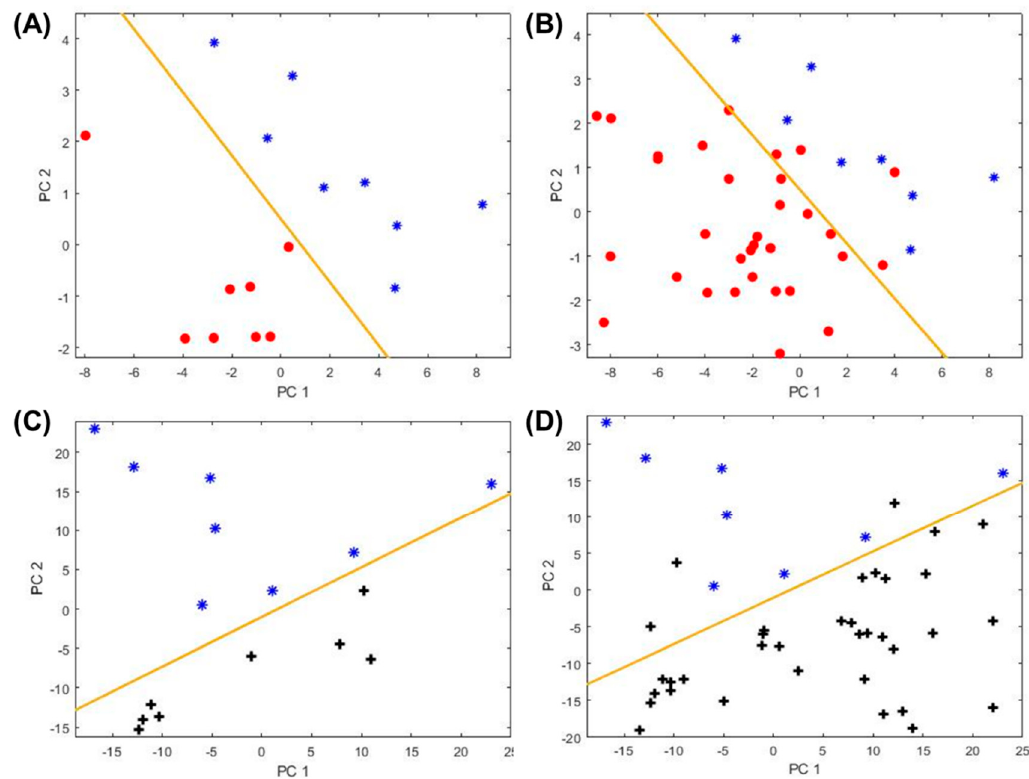
Figure 3. Classification among asthma (red circles), and non-asthma/non-atopic (black crosses), and non-asthma atopic (blue asterisks) subjects. ( A ) PCA plot for the asthma and atopic subjects in the training set using a new set of biomarkers listed in Table 1. ( B ) Corresponding PCA plot for the training set and the testing set combined. ( C ) PCA plot for the non-asthma atopic and non-asthma/non-atopic subjects in the training set using the biomarkers listed in Table 1. ( D ) Corresponding PCA plot for the training set and the testing set combined. The yellow line marks the position of the boundary.